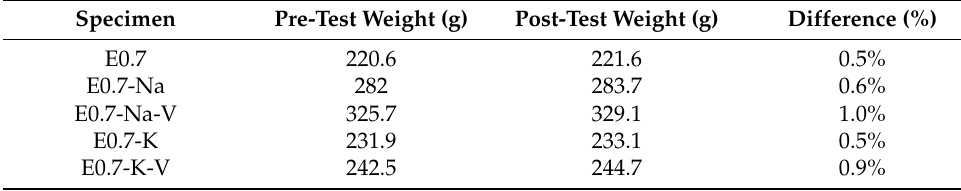
Table 6. Water retention from water vapour